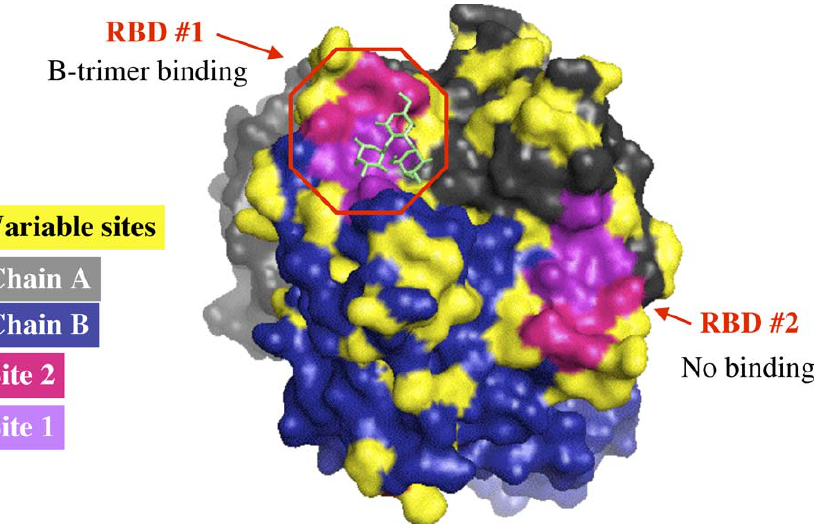
Figure 4. Variation Mapped to the VA387 Dimer Capsid dimerization creates two identical RBD that have been shown to bind to carbohydrate receptors. Each domain contains two sites that facilitate binding, with site 1 directly binding the a -fucose of B-trimer, shown in RBD#1 in this depiction. Interaction site 2 likely governs specificity, as it provides weak, long-distance interactions to the b -gal group of the B-antigen. Purple, site 1; pink, site 2; yellow, sites that have changed over 20 years of evolution; gray, chain A monomer; blue, chain B monomer; green, B-trimer